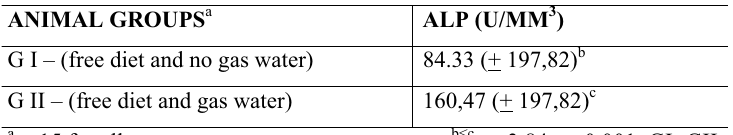
TABLE 3 – Medium values of the levels of alkaline phosphatase, seric in international unities by cubic millimeters (U/mm3) and respective standard deviation, in the experimental